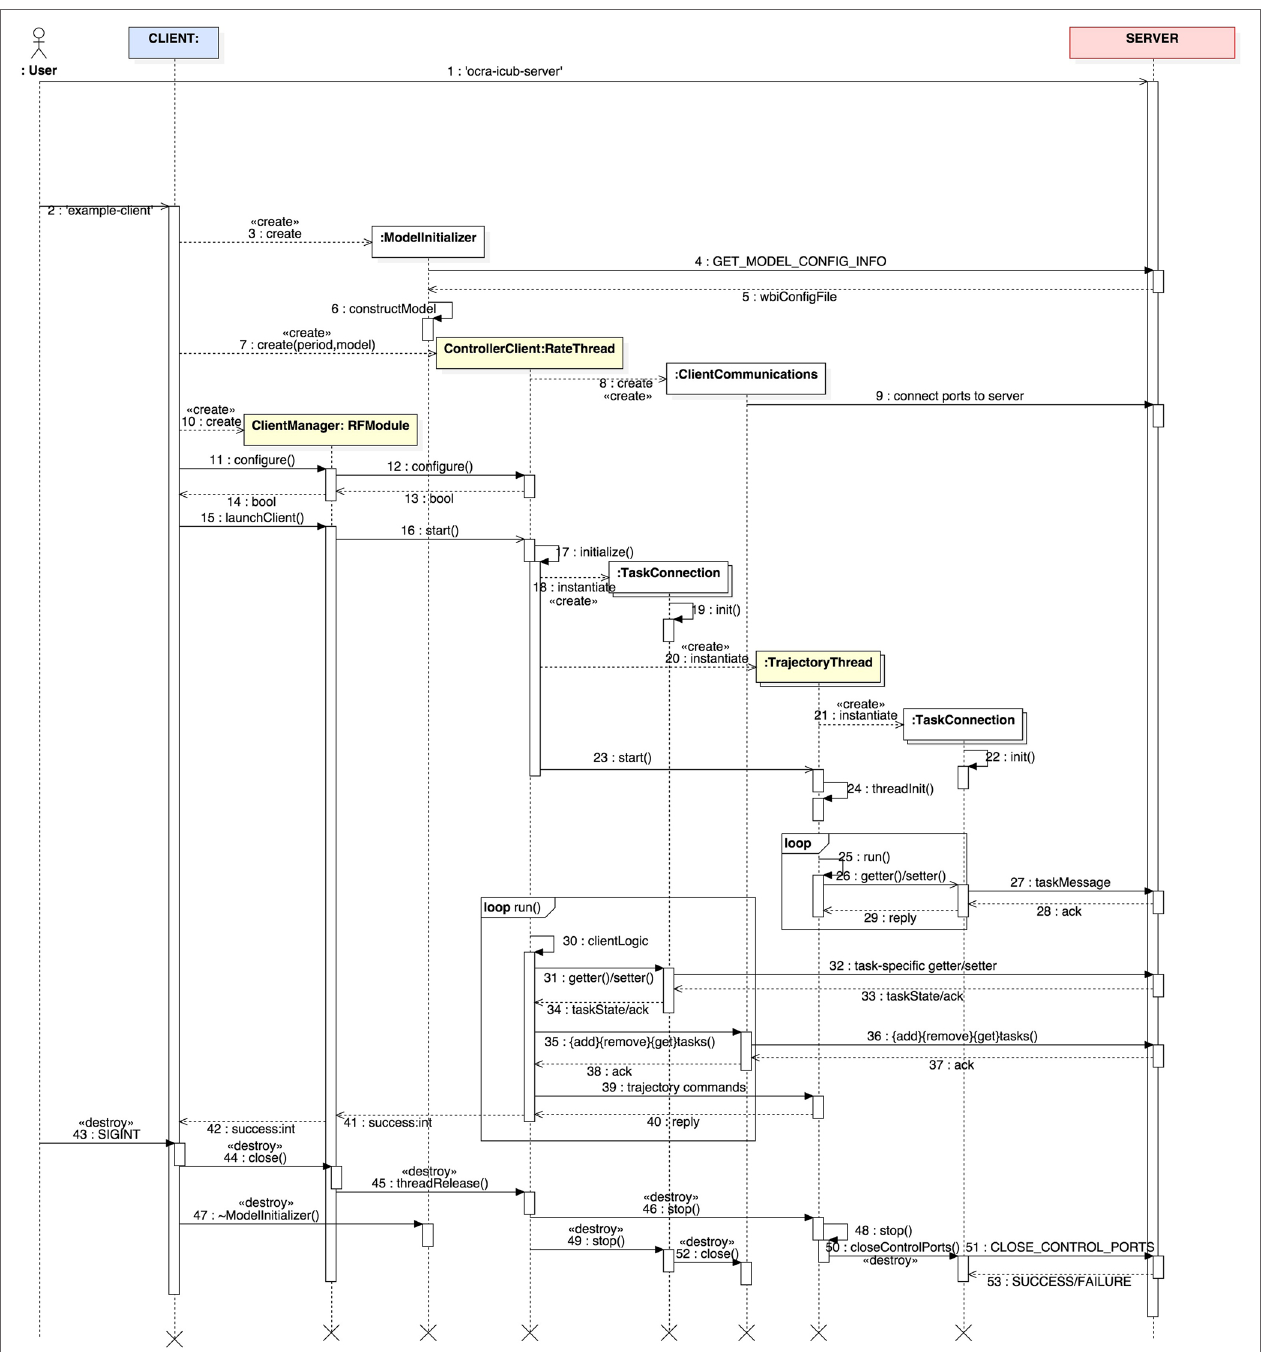
FIGURE 3 | UML sequence diagram displaying the typical interactions within a generic client. The time evolution of interactions is followed from top to bottom, while messages passed among objects are found in the horizontal dimension. The light yellow background of some lifelines indicate that these are